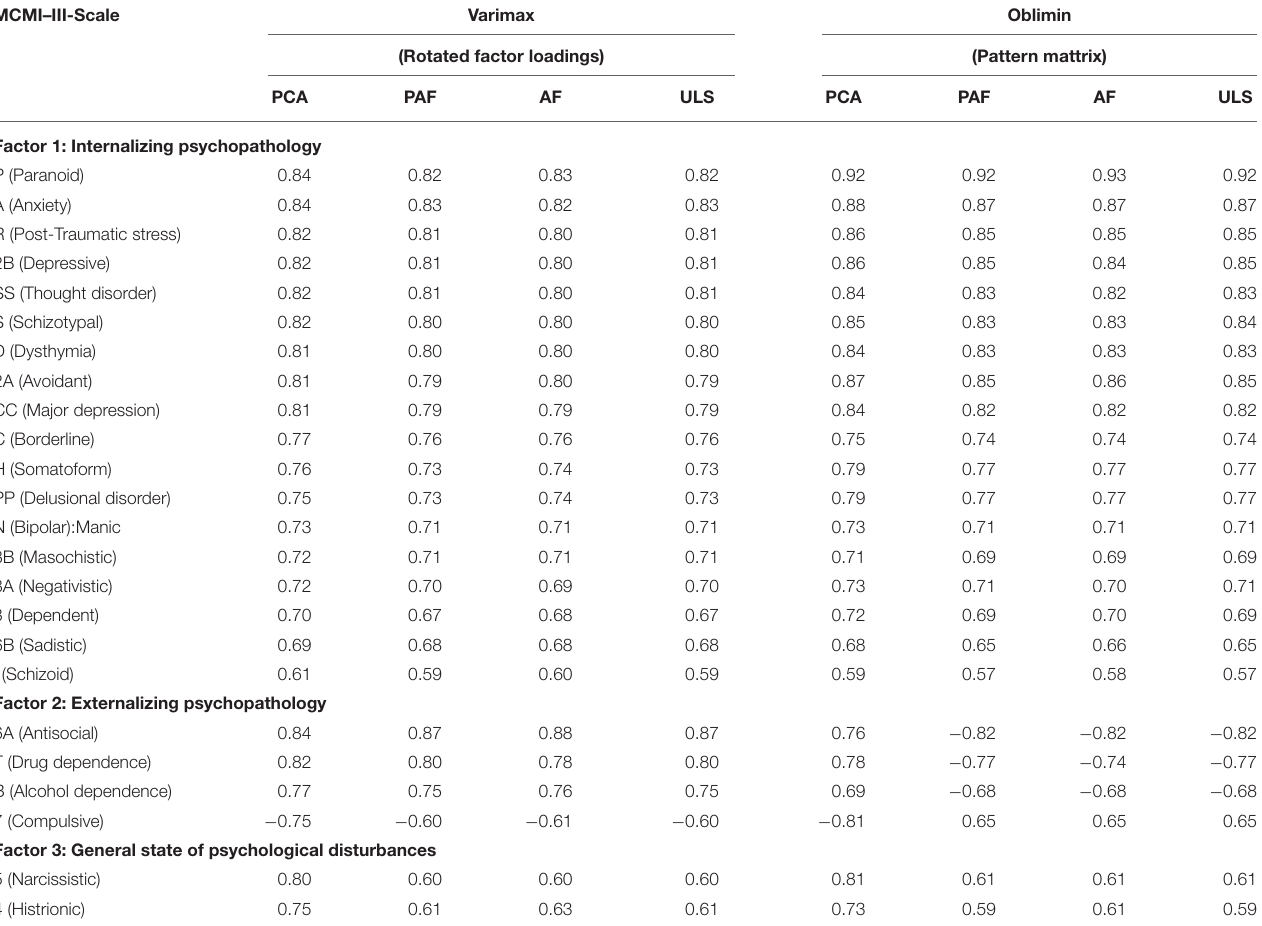
TABLE 5 | Factor loadings for the MCMI-III scales under four extraction and two rotation methods. MCMI–III-Scale